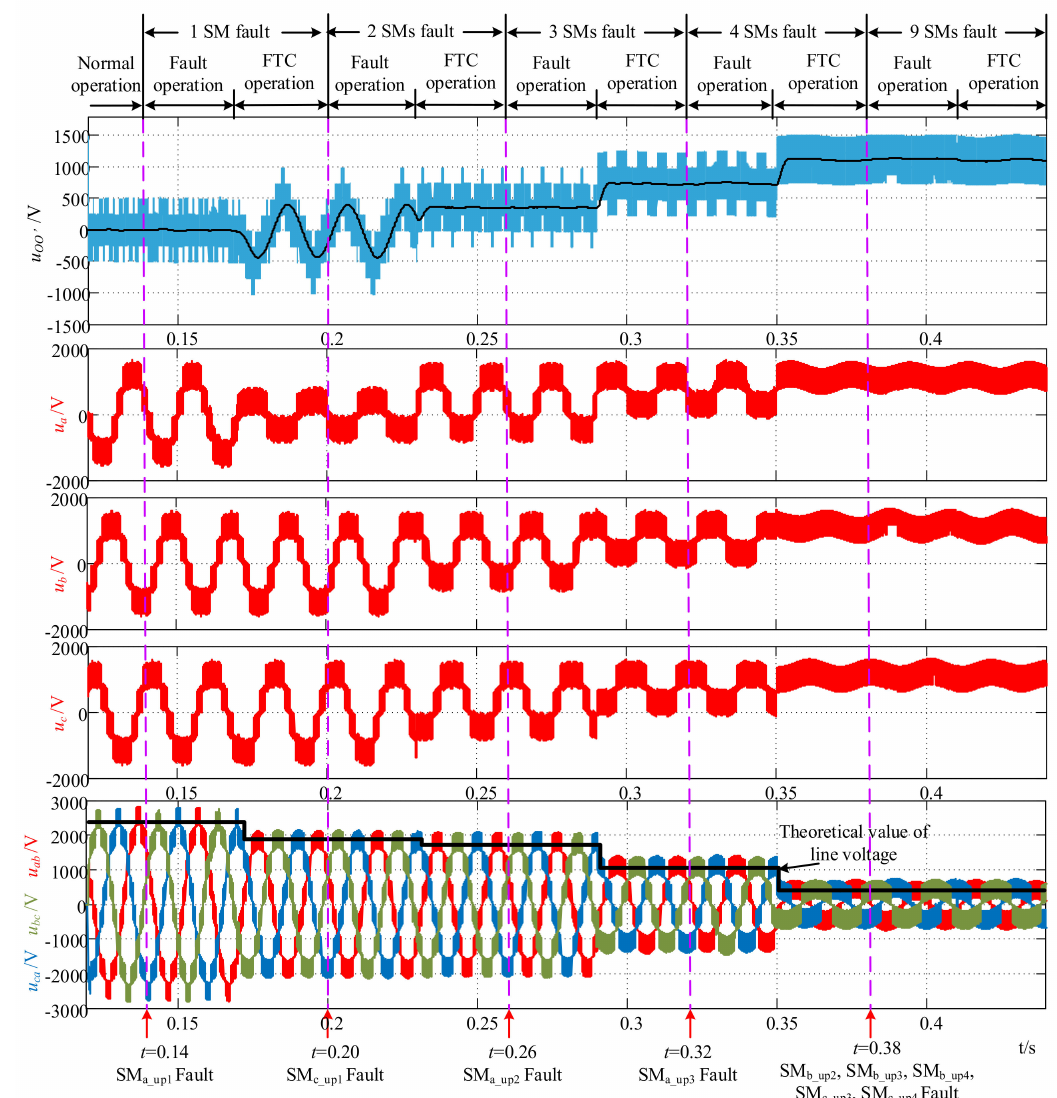
Figure 13. The waveforms of the neutral point shift voltage, the three-phase output phase voltage and line